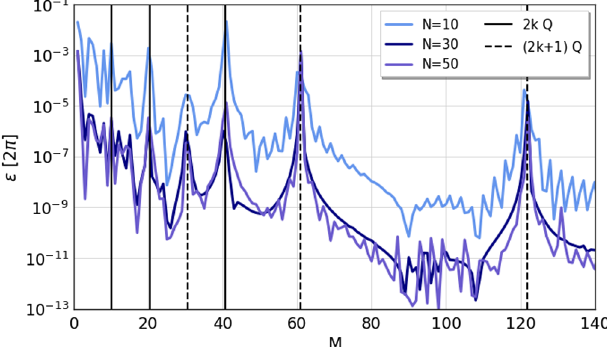
FIG. 4. Appearance of resonances in the mixed BPM analysis of the numerical simulations, due to a rational Q=M . The measurement error ϵ is shown in the logarithmic scale, for three cases of N , against the number of BPMs M . The even resonances are indicated with thick lines, while the odd resonances with dashed lines.